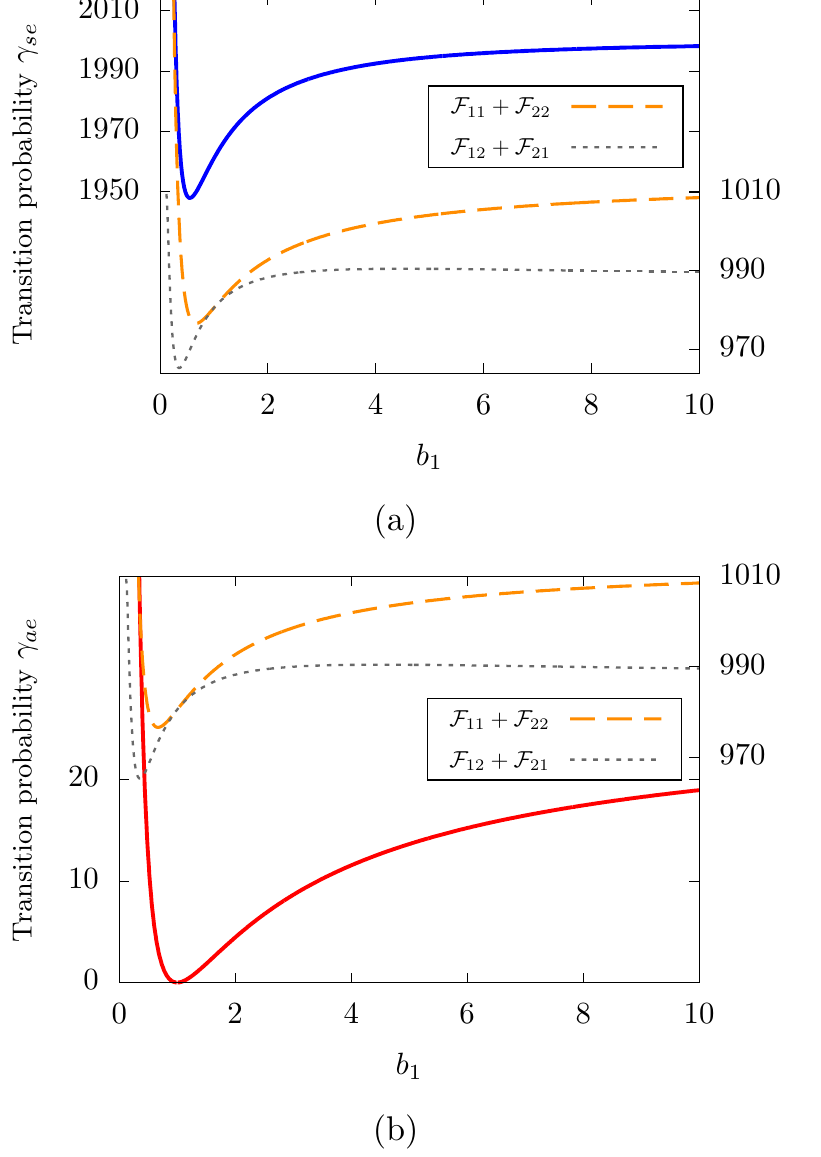
Figure 2 . (1 + 1) dimensions: (a) The transition probability from the symmetric state to the collective excited state denoted by the solid blue line. (b) The transition probability from the anti-symmetric state to the collective excited state denoted by the solid red line. In both of the plots the sum of the transition coefficients ( F 11 + F 22 ) for the transitions from the symmetric or anti-symmetric states to the excited state are denoted by orange dashed lines. The sum of the transition coefficients ( F 12 + F 21 ) for the transitions from the symmetric or anti-symmetric states to the excited state are denoted by gray dotted lines. In all of the above cases b 2 = 1 is kept fixed and b 1 is varied. The value of the other parameters are ∆ E = 0 . 1 , ω k = 0 . 1 and β = 2 π